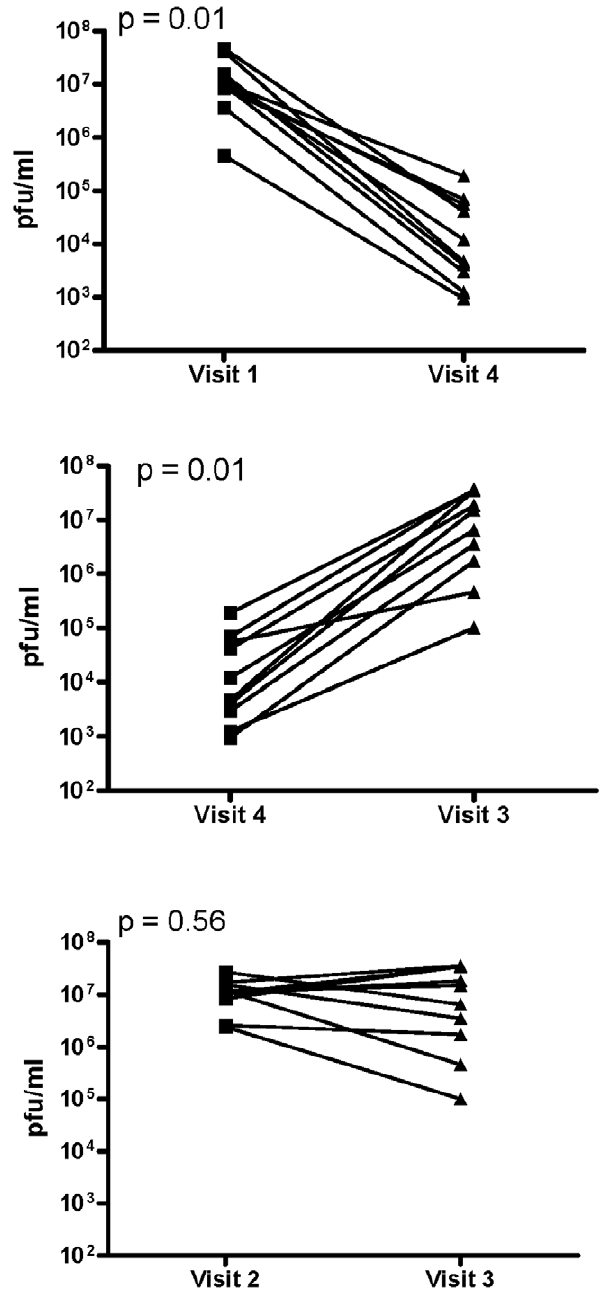
Figure 3. Loss in the anti-HSV activity in CVL collected following PRO 2000 gel application in the absence or following coitus. CaSki cells were infected with serial 10-fold dilutions of HSV- 2(G) mixed with each CVL sample. After incubation for 2 h, the inoculum was removed by washing and the cells were overlaid with fresh media. Infection was monitored by counting plaques after 48 h. Results are viral titer (pfu/ml) calculated from 2 independent experiments where each sample was tested in duplicate. The upper panel shows results for each subject for Visit 1 (baseline) versus Visit 4 (post-gel), middle panel for Visit 4 (post-gel) versus Visit 3 (post-gel and postcoital) and lower panel for Visit 2 (postcoital) versus Visit 3 (post-gel and postcoital).